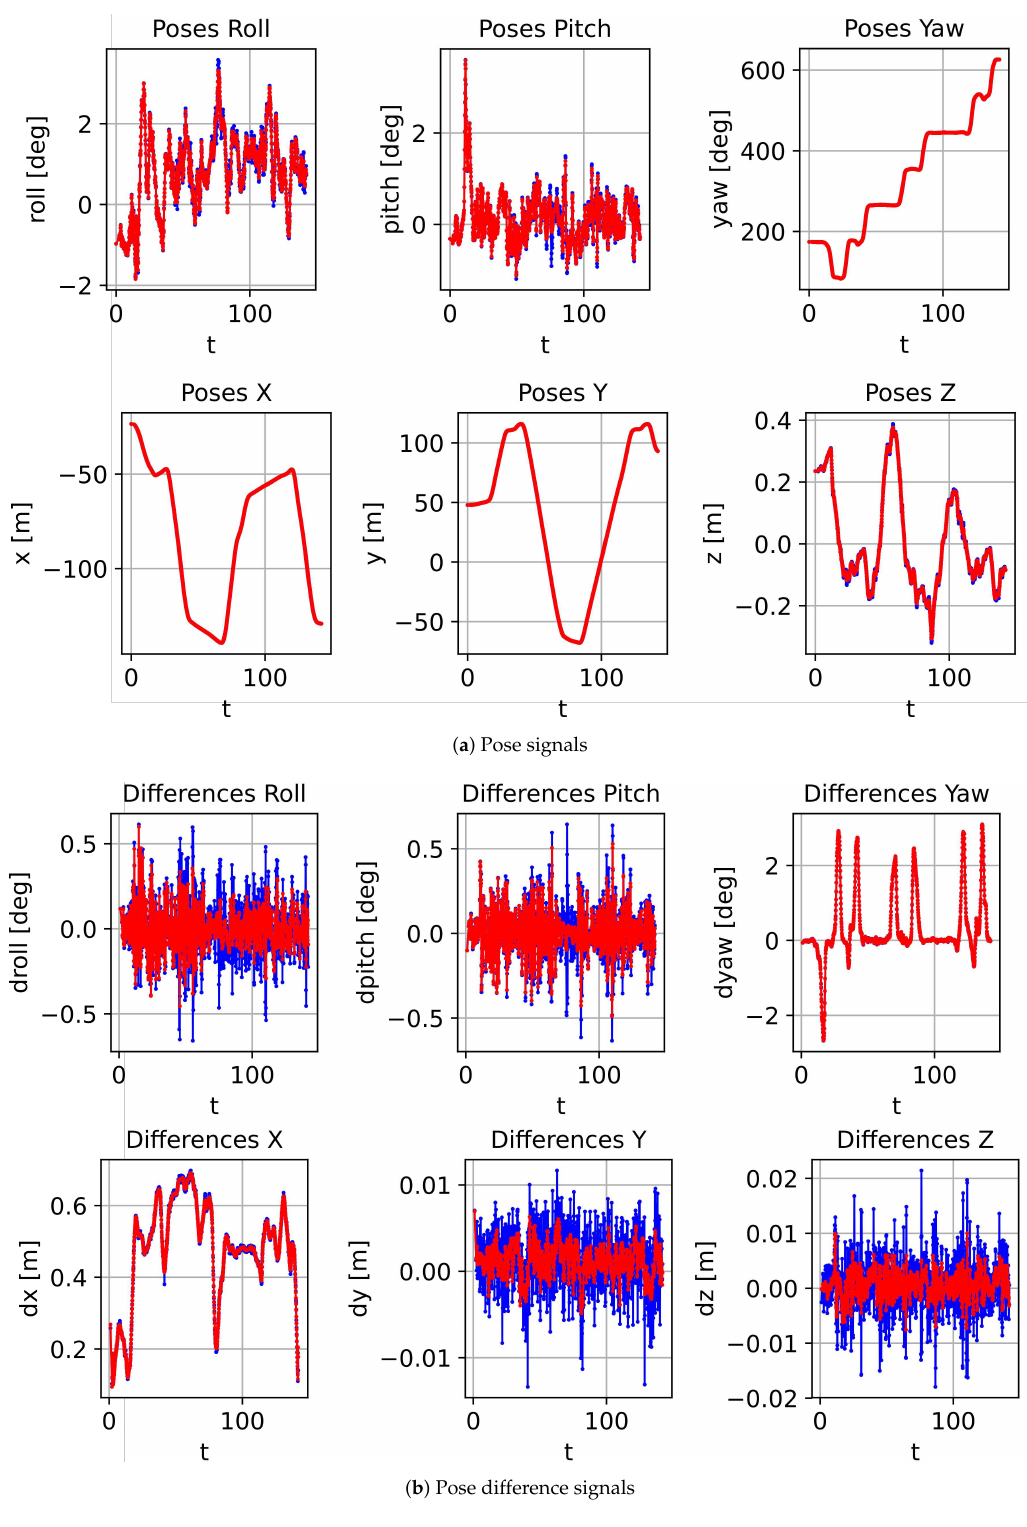
Figure 4. Pose signals and pose difference signal details of the visual localization results (highlighted with blue color) and the fused results by applying our uniform B-spline-based motion fusion approach (highlighted with red color). ( a ) The pose signals. ( b ) The pose difference signals. From the plotting, by fusing the IMU measurements, the fusion results are smoother and more